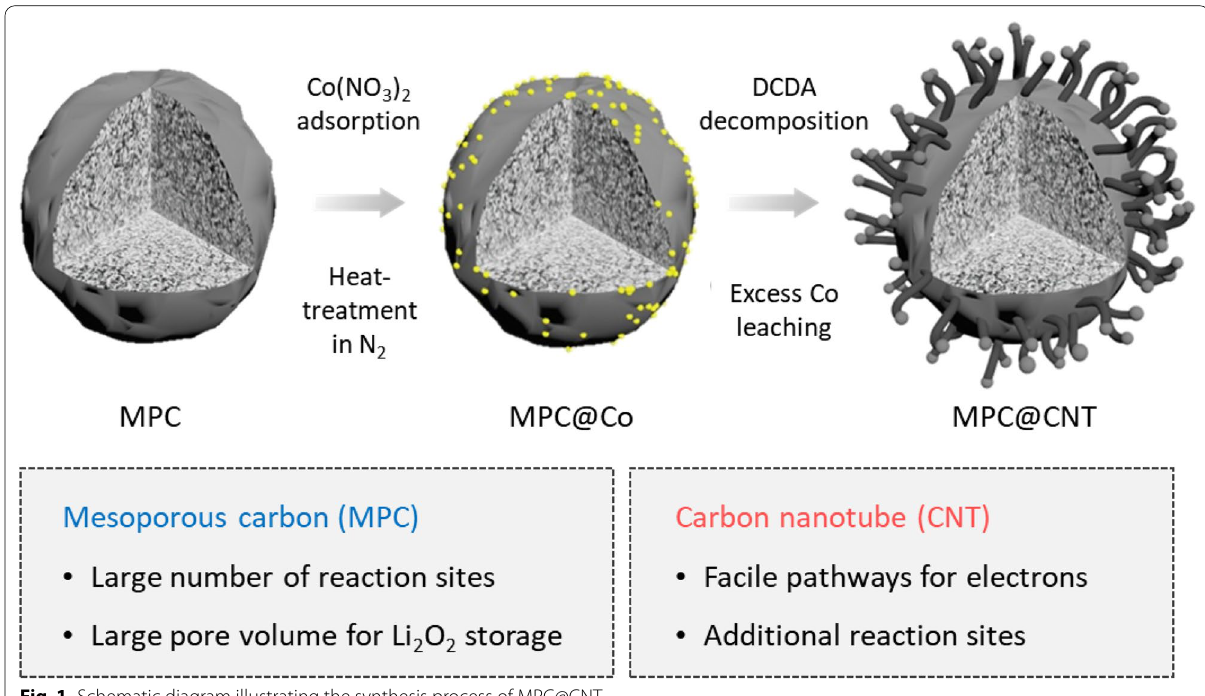
Fig. 1 Schematic diagram illustrating the synthesis process of